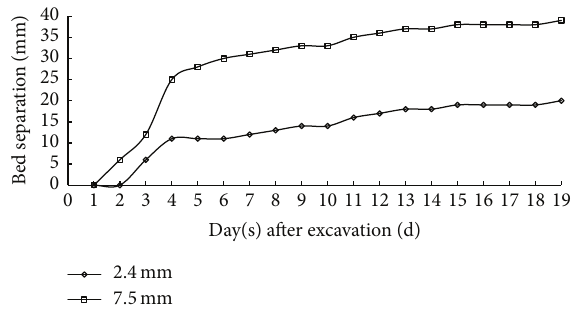
Figure 18: Bed separation of the roof after excavation versus time.